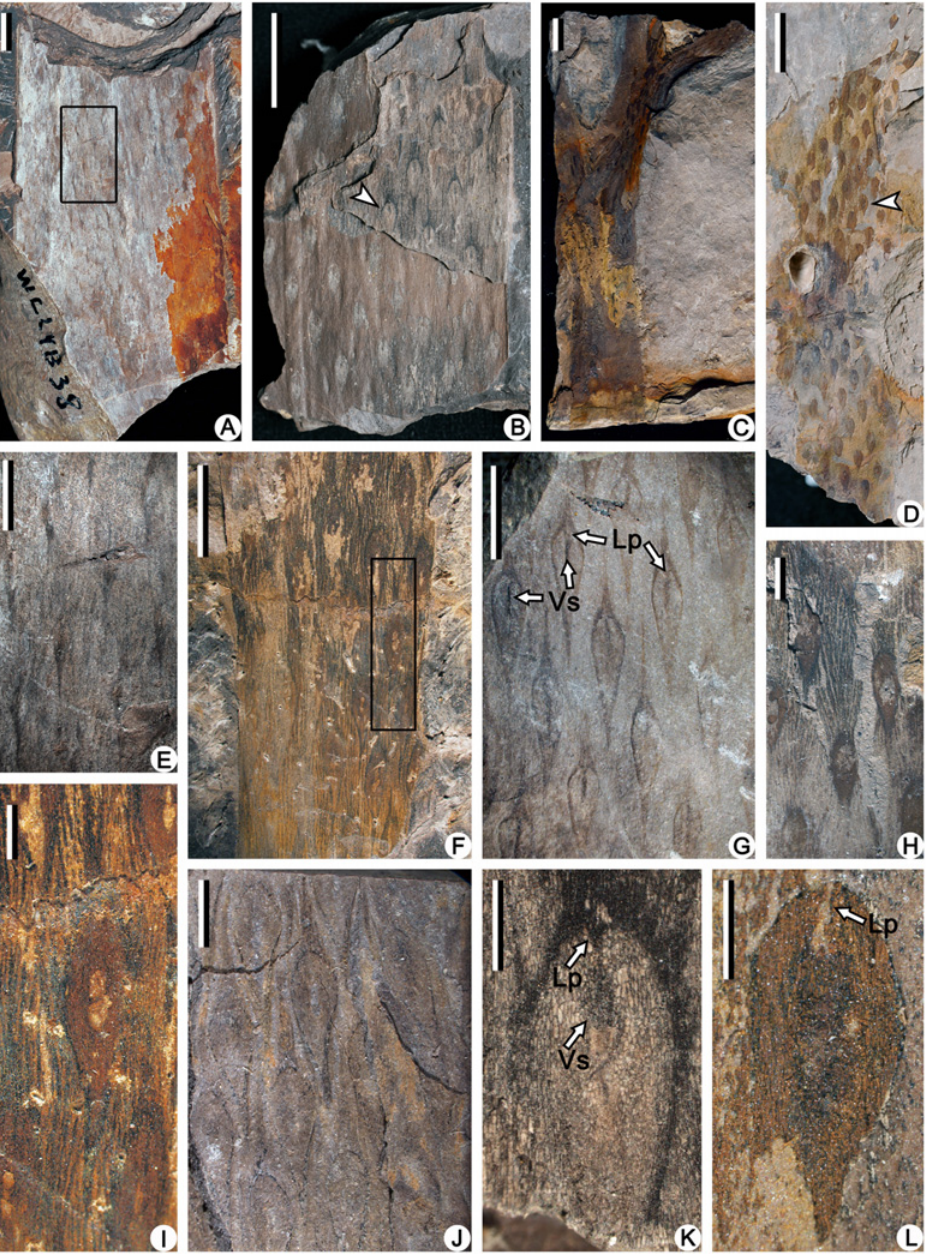
Fig 1. Compressions of vegetative axes of Minostrobus chaohuensis . (A) The widest stem. Rectangle indicating portion enlarged in Fig. 1E. PKUB12138. Scale bar = 10 mm. (B) Stem with the lower left part without epidermis, showing leaf cushions. Arrow indicating portion enlarged in Fig. 1K. PKUB12145. Scale bar = 10 mm. (C) Stem dichotomizing two times. PKUB12101. Scale bar = 10 mm. (D) Vegetative axis with leaf cushions arranged in helix. Arrow indicating portion enlarged in Fig. 1L. PKUB12137. Scale bar = 10 mm. (E) Enlargement of Fig. 1A (rectangle), showing parastichies of leaf cushions. PKUB12138. Scale bar = 5 mm. (F) Vegetative axis with leaf cushions arranged in helix. Rectangle indicating portion enlarged in Fig. 1I. PKUB12135. Scale bar = 5 mm. (G) Vegetative axis with long fusiform leaf cushions, showing leaf scars, ligule pits (Lp) and vascular scars (Vs). PKUB12171. Scale bar = 5 mm. (H) Vegetative axis showing interareas with vertical linear ornamentations among leaf cushions. PKUB12163. Scale bar = 2 mm. (I) Enlargement of Fig. 1F (rectangle), showing long fusiform leaf cushion and ornamentations on the interareas. PKUB12135. Scale bar = 1 mm. (J) Vegetative axis with leaf cushions, showing the oblanceolate leaf scars. PKUB12148. Scale bar = 2 mm. (K) Enlargement of Fig. 1B (arrow), showing leaf scar, ligule pit (Lp) and vascular scar (Vs). PKUB12145. Scale bar = 1 mm. (L) Enlargement of Fig. 1D (arrow), showing leaf scar and ligule pit (Lp). PKUB12137. Scale bar = 1 mm.